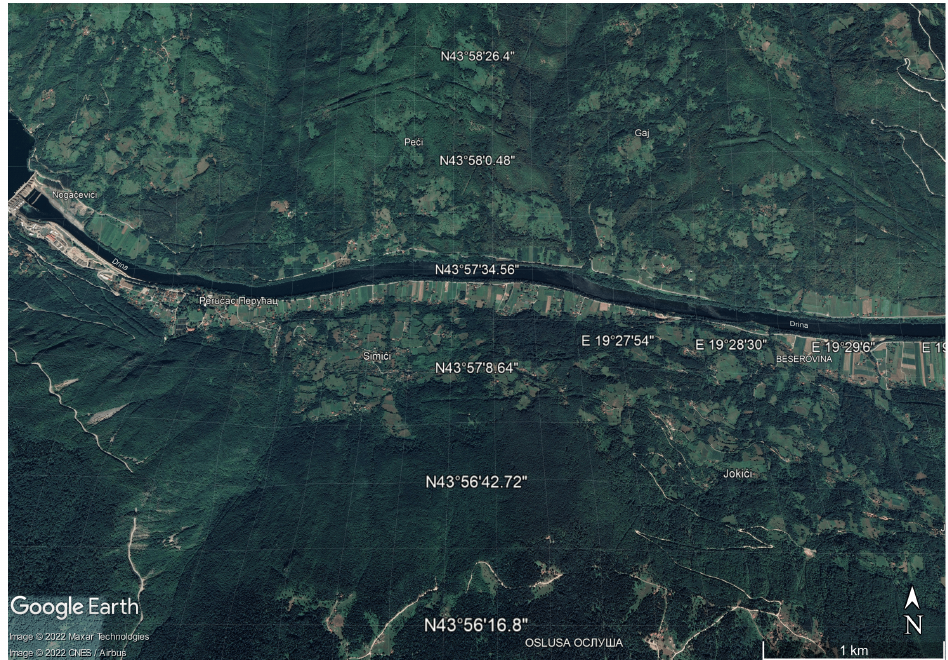
Figure 20. RGB image of Drina River system after Bajina Basta hydroelectric dam, Serbia, acquired 28th August 2020. Areas of white water and embankments seen throughout the system. (Credits: Google/CNES Airbus).